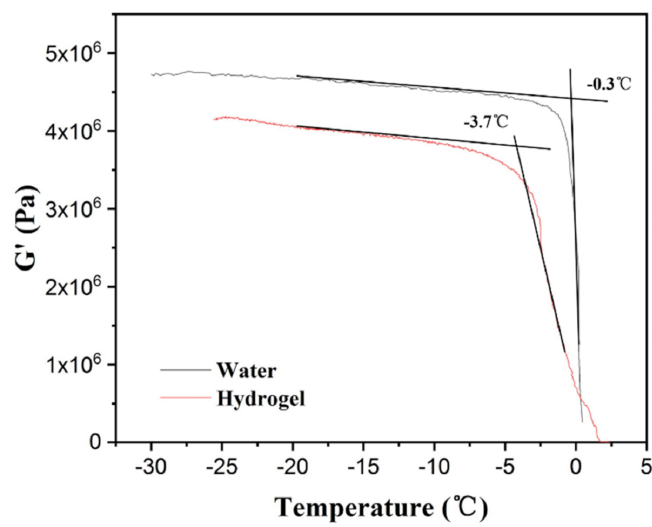
Figure 11. G’ versus temperature curves of water and